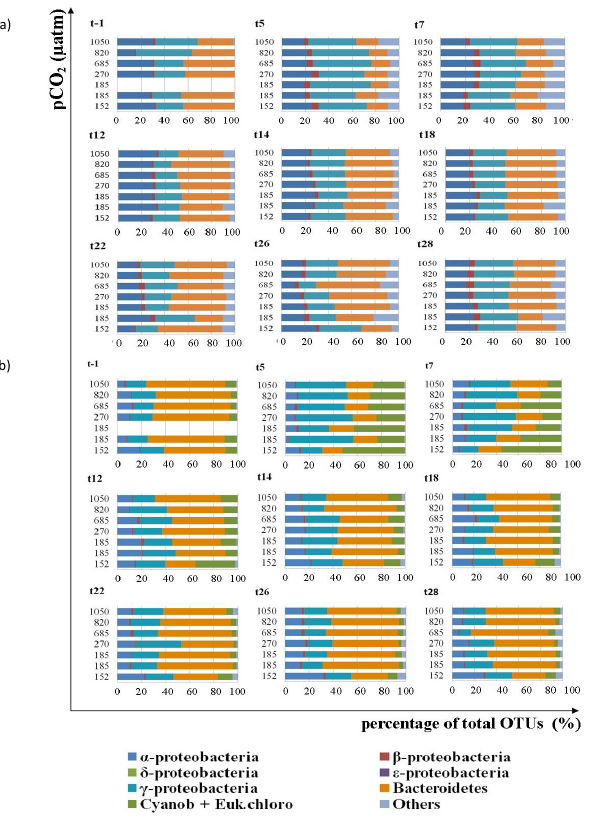
Fig. 2. Microbial community overview of the most abundant phyla in (a) the small size fraction (0.2-3 µm) and (b) the large size fraction (3-20 µm) during t-1, t5, t7, t12, t14, t18, t22, t26 and t28; x-axis represents percentage of total OTUs and y-axis represents pCO 2 in µatm.